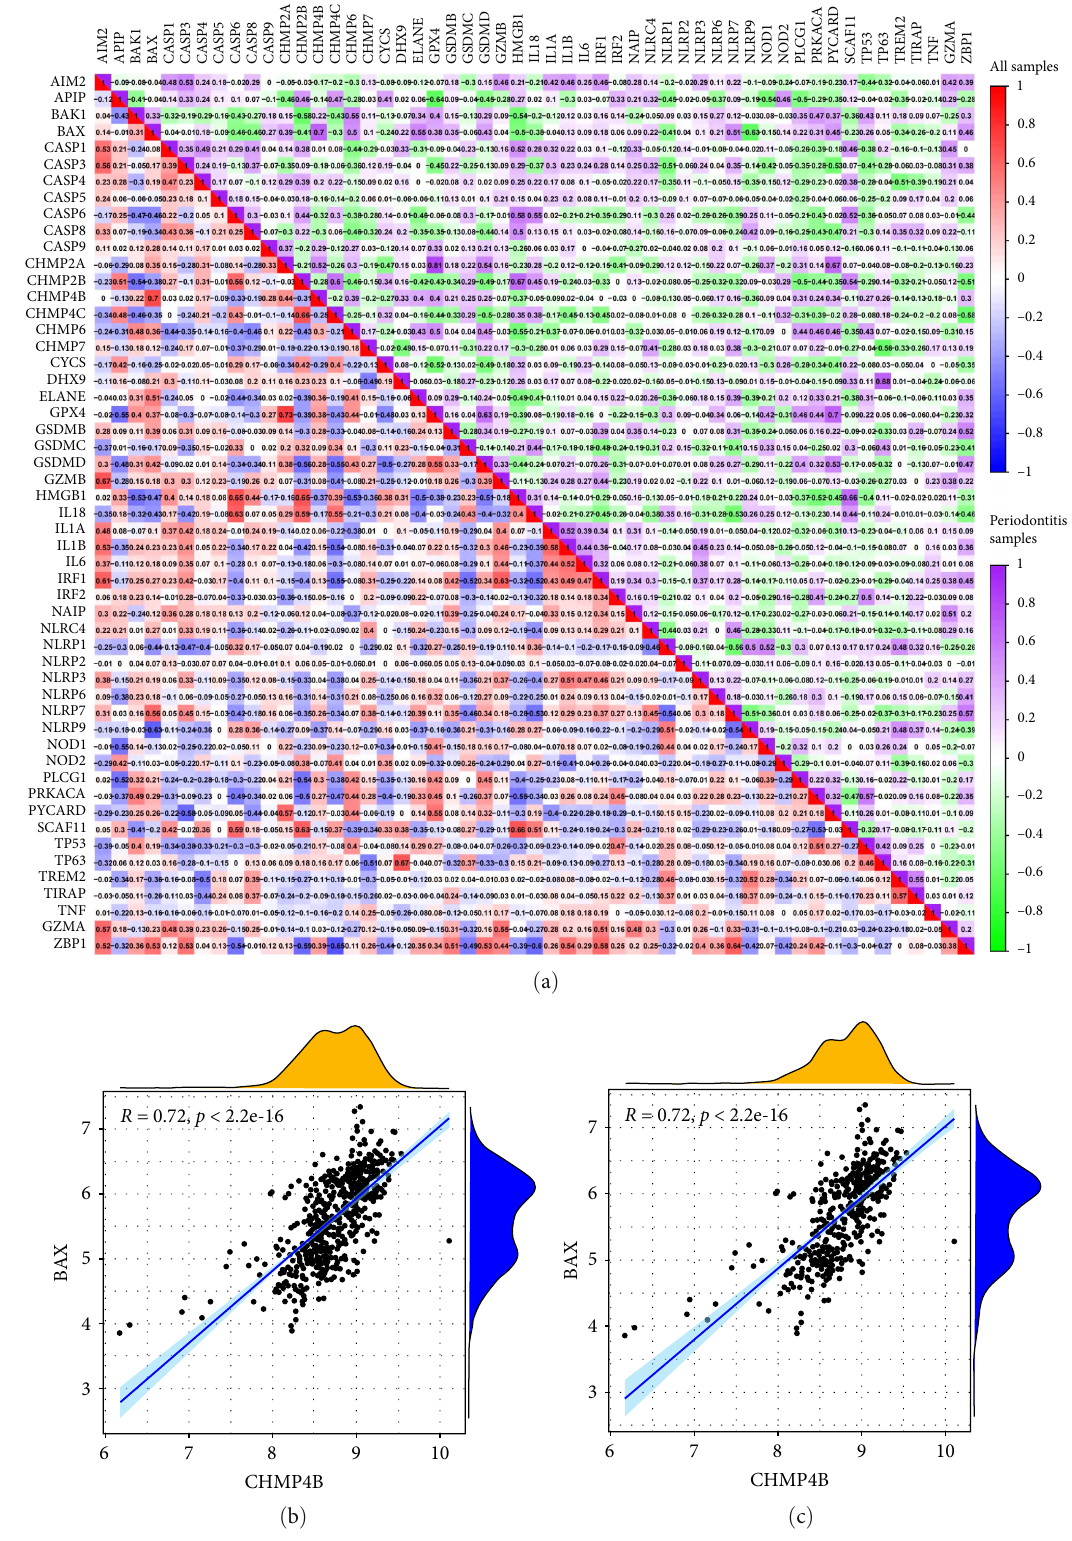
F IGURE 3: Correlations among 53 PRGs in all samples and periodontitis samples. (a) Correlations among 53 PRGs in all samples and periodontitis samples. (b) CHMP4B and BAX had the highest signi fi cant correlation in all samples. (c) CHMP4B and BAX had the highest signi fi cant correlation in periodontitis samples. PRG, pyroptosis-related